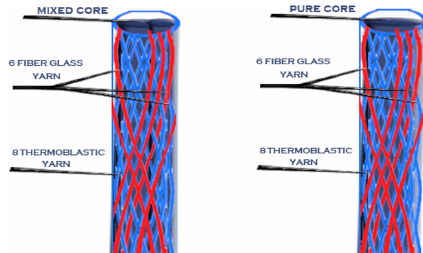
Figure 5. Sample 3 with different cores.